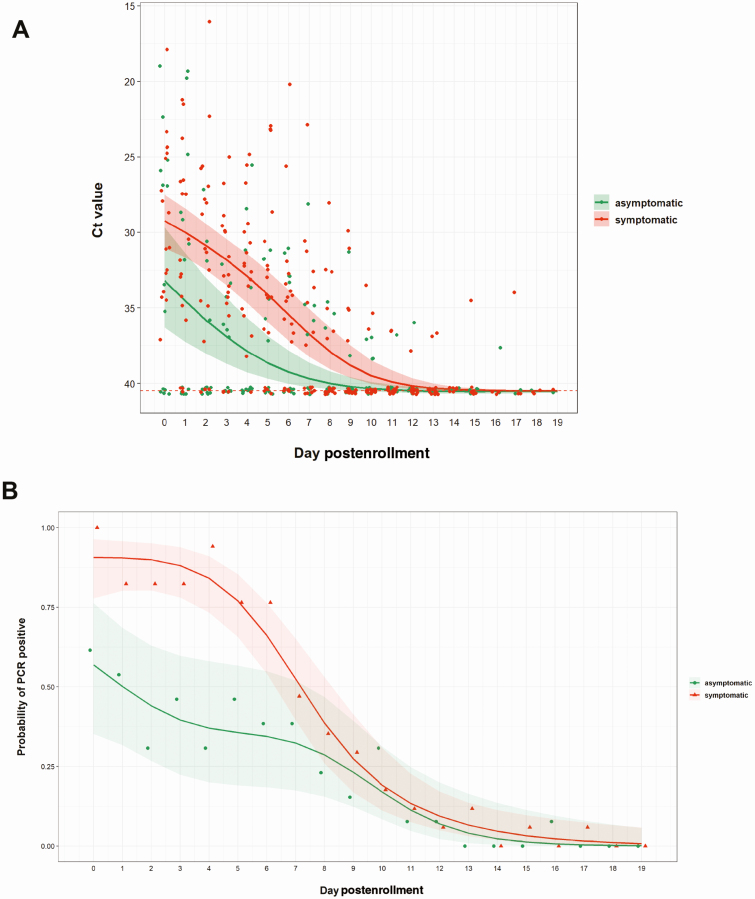
Trends in cycle threshold (Ct) values and viral detection probability in nasopharyngeal/throat swabs over the course of hospitalization. A, Changes of Ct values relatively reflect the level of viral load. B, Dynamics of viral detection probability from enrollment onward. Each dot represents 1 observed value (A) or the mean value (ie, frequency) per day (B); lines indicate mean and shades indicate 95% confidence interval. Abbreviations: Ct, cycle threshold; PCR, polymerase chain reaction.